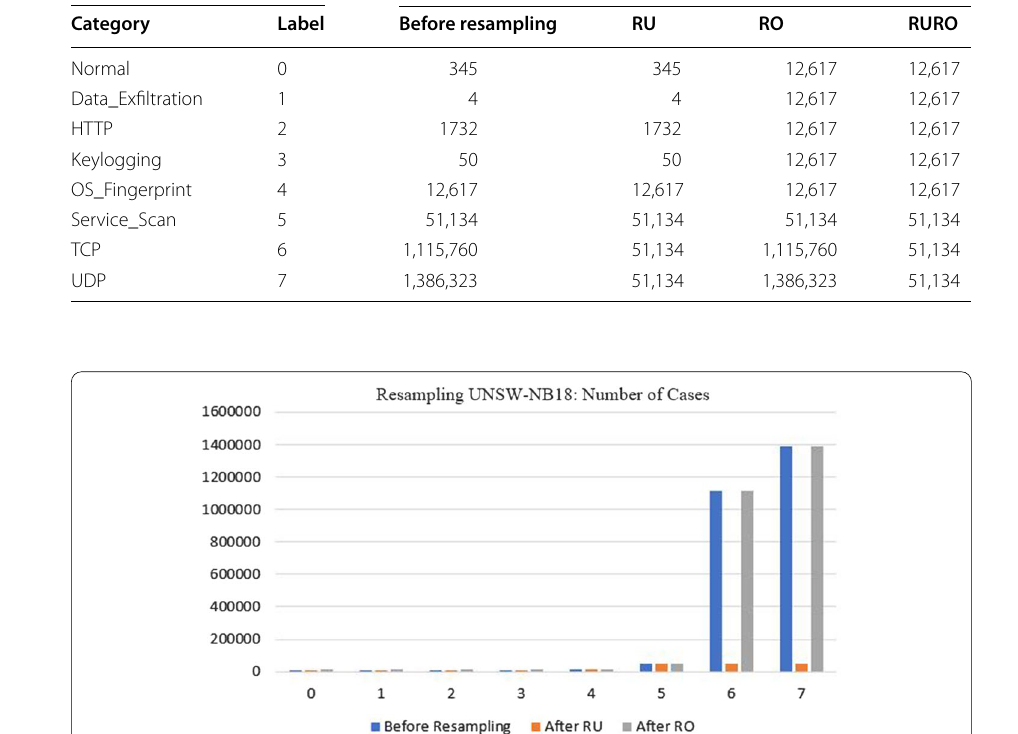
Table 28 Resampling of UNSW-NB18 (BoT-IoT) Number of cases for training model